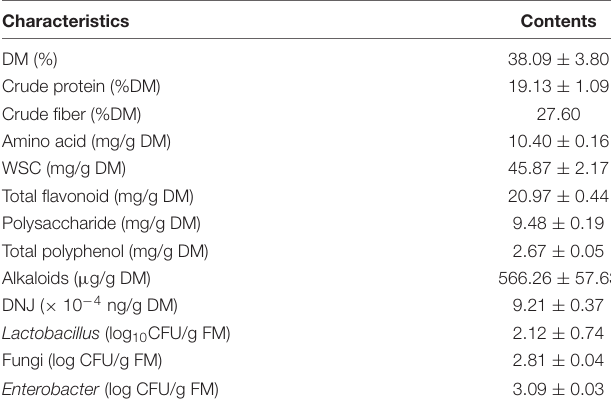
TABLE 1 | Chemical and microbial composition of pre-ensiled mulberry